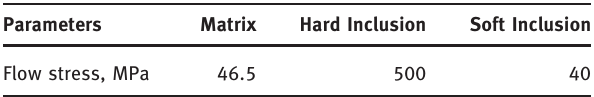
Table 2: Flow stress.